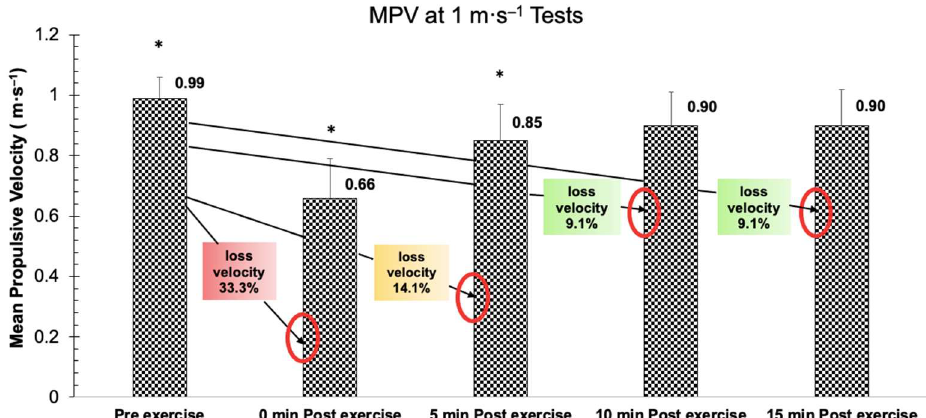
Figure 4. MPV at 1 m · s − 1 before the BP exercise protocol and at minute 0, 5, 10 and 15 after the exercise. * = significant difference between all sets ( p < 0.05).